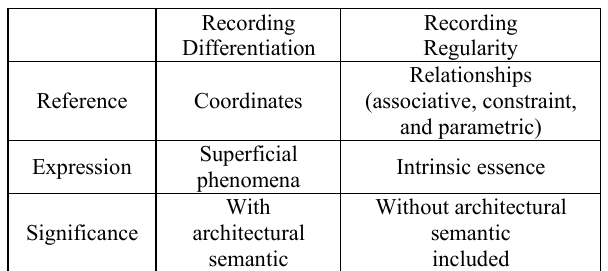
Table 1. Comparison of recording “differentiation”